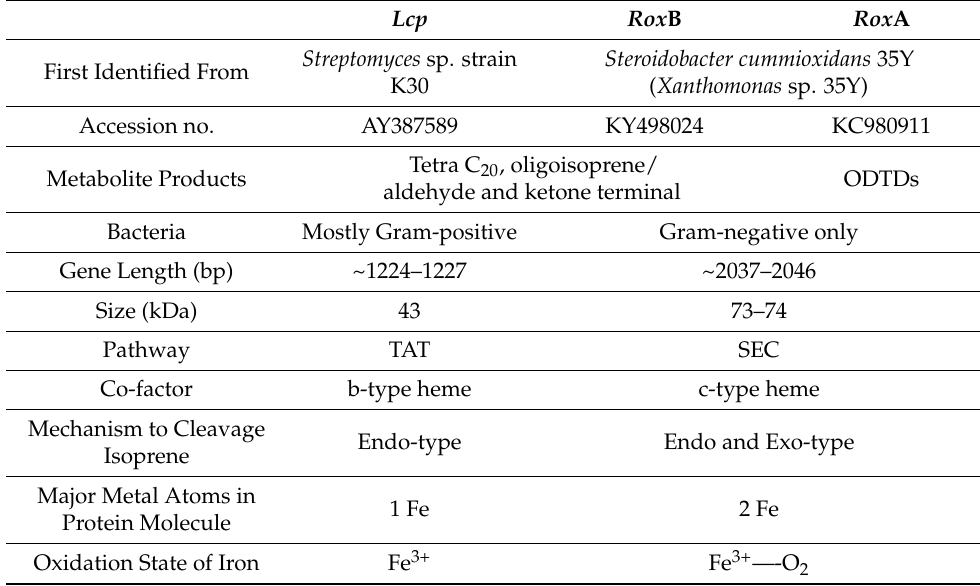
Table 1. Summary of rubber oxygenase’s main characteristics